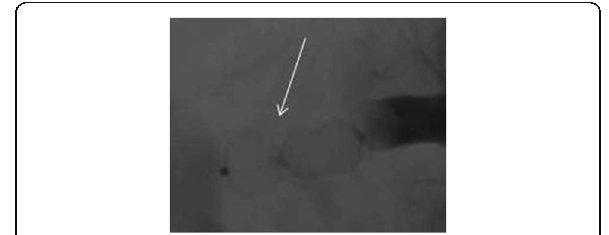
Fig. 6 The structural characteristics of the AVP II that is composed of 3 lobes and a